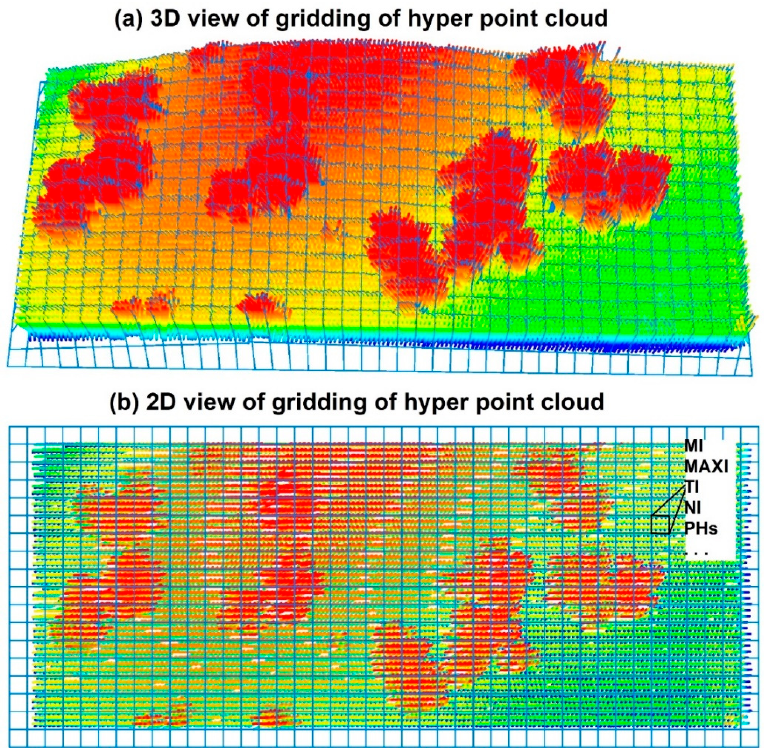
Figure 4. The gridding of the hyper point cloud (HPC). ( a ) 3D view of the HPC with grid-nets. ( b ) Derivation of variables such as the mean intensity (MI), the maximum intensity (MAXI), the total intensity (TI), the number of intensities (NI) and multiple percentile heights (PHs) at the grid cell level with the gridding procedure from the 2D perspective.